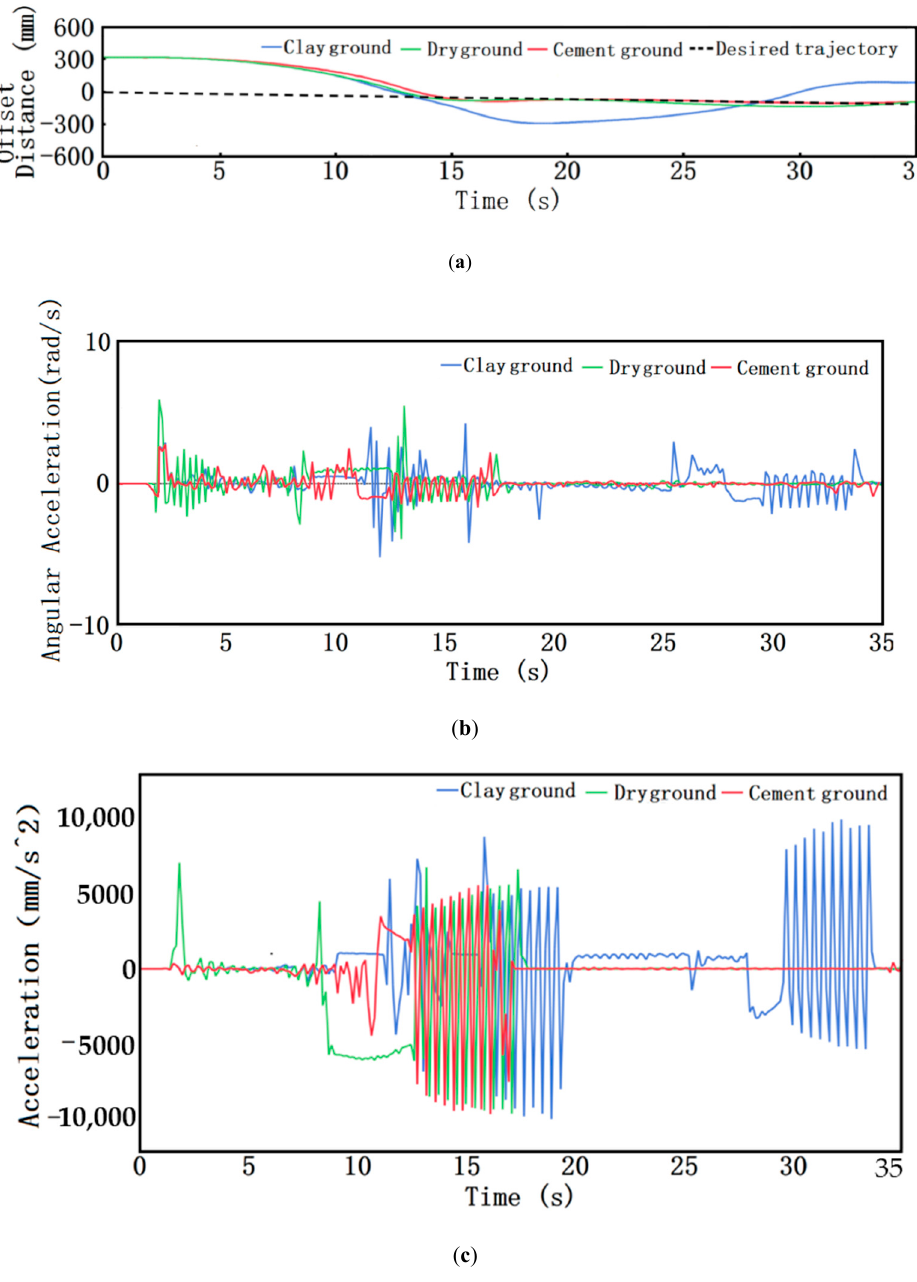
Figure 15. Simulation results: ( a ) Path tracking results of robot on different roads; ( b ) Acceleration diagram of robot’s yaw angle under different road conditions; ( c ) Yaw acceleration diagram of robot under different road conditions.